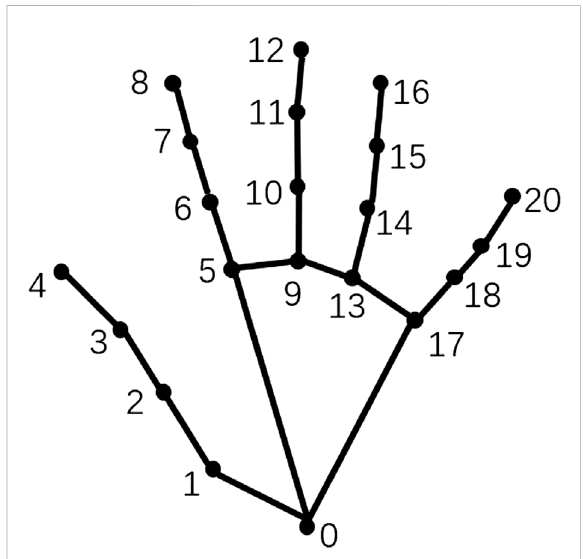
FIGURE 1 The hand skeleton graph. The nodes denote the hand joints and the edges denote the connections.